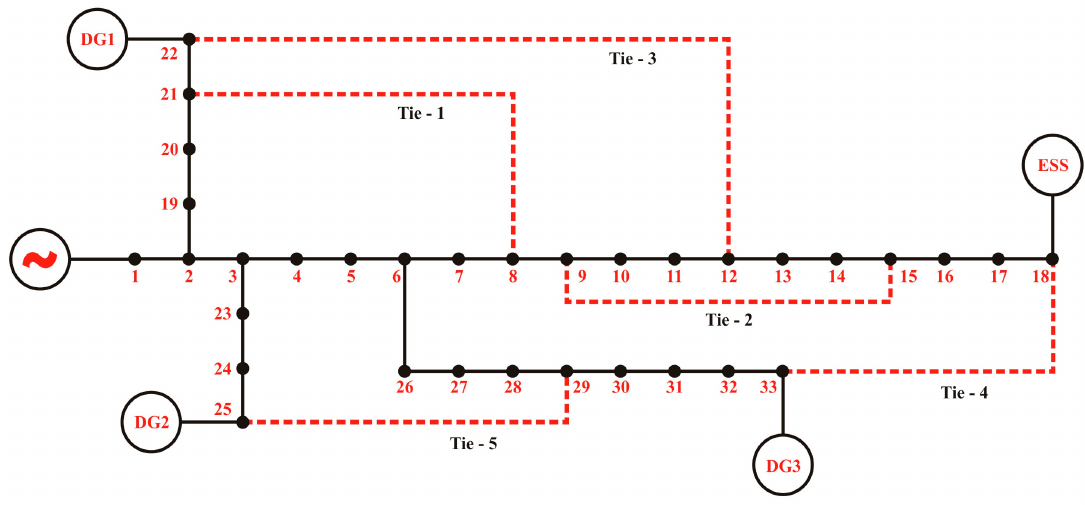
Figure 4. IEEE 33-bus system.